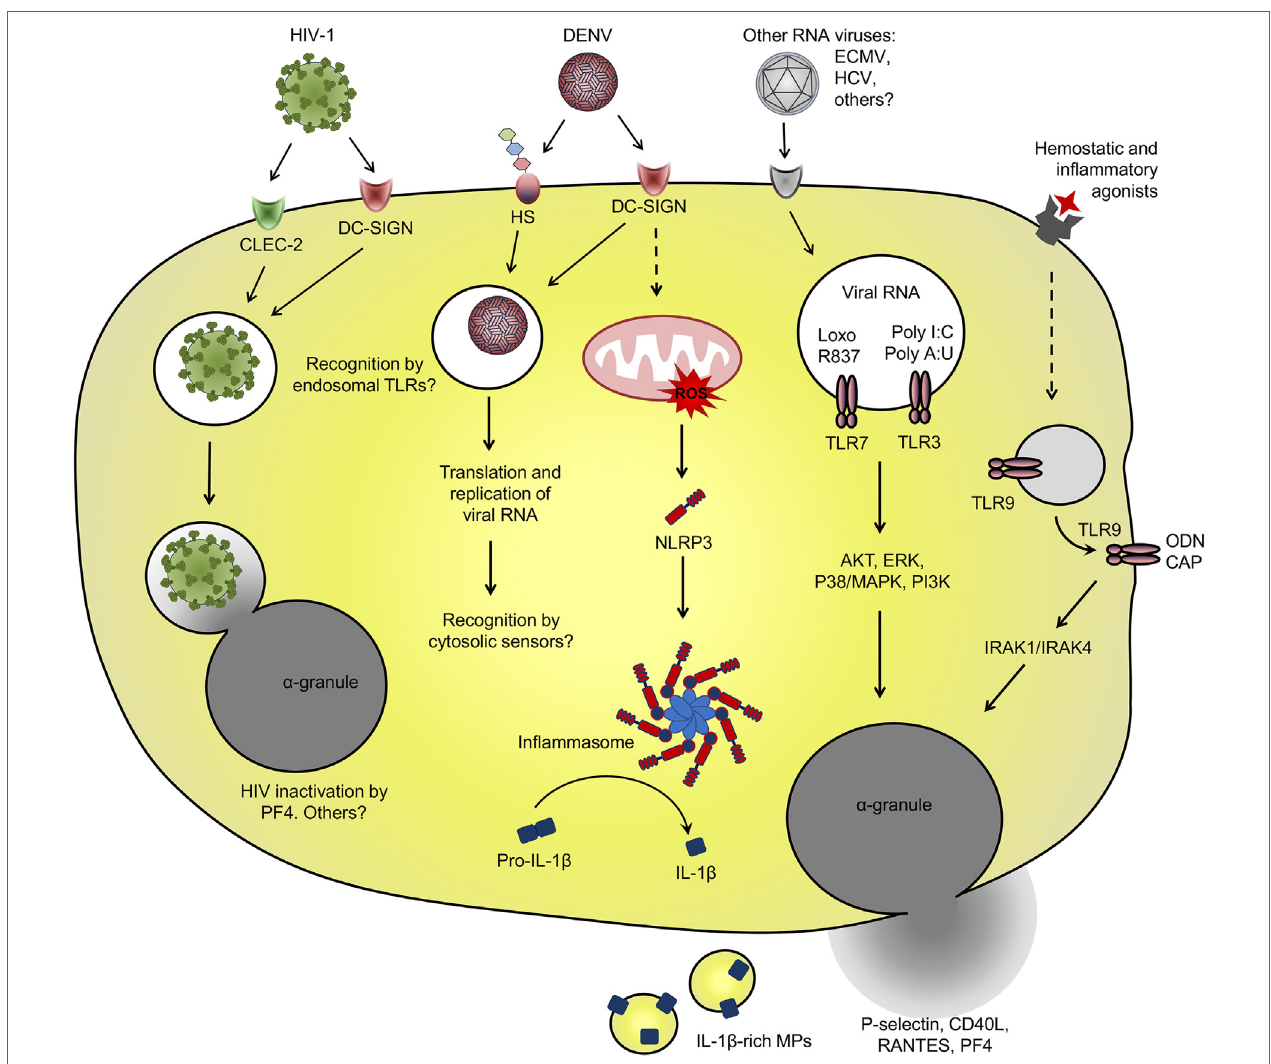
FigURe 1 | Platelet interaction with viruses and virus-related pathogen-associated molecular patterns (PAMPs): schematic representation of the main receptors and pathways involved in virus binding and internalization, and pattern recognition receptor involved in recognition of viral PAMP by platelets. See text for details and